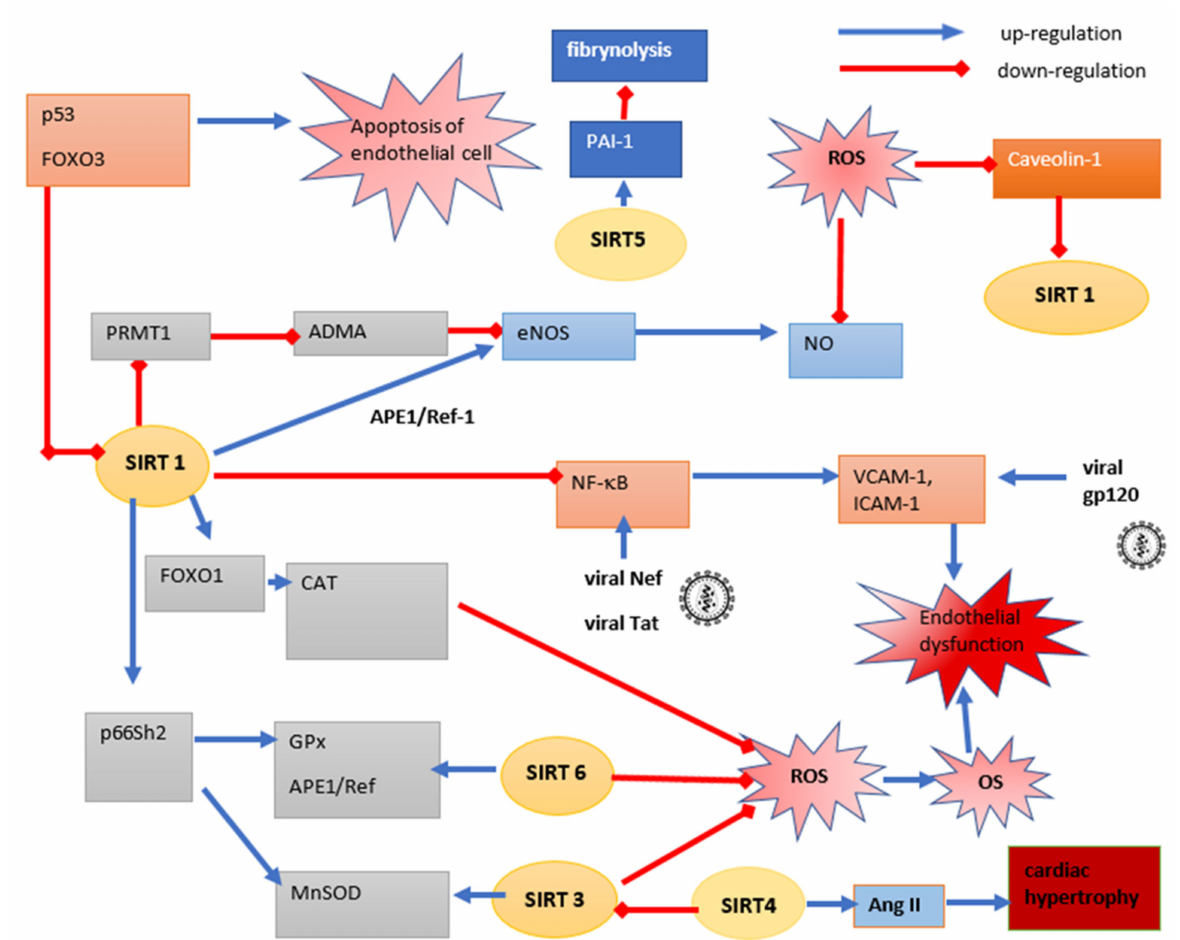
Figure 3. Scheme of connection between cardiovascular disorders, sirtuins and HIV infection. SIRT1 deacetylate PRMT1 and decrease levels of ADMA—eNOS inhibitor. SIRT1 is also responsible for deacetylation of eNOS, which increases enzyme activity and the production of NO. Endothelial SIRT1 activity against eNOS is promoted by APE1/Ref-1. SIRT1 decrease activity of p53, preventing process of apoptosis in endothelial cells. SIRT1 also deacetylates FOXO1, which has a positive effect on the regulation of apoptosis and cell cycle regulation. Decetylated FOXO1 increases the concentration of CAT and MnSOD. SIRT1 deacetylates Lys-310 in the RelA/p65 complex in NF- κ B, suppressing its pro-inflammatory activity in response to OS, and inhibits the synthesis of pro-inflammatory cytokines or thrombotic factors (ICAM-1, VCAM-1). The protective role of SIRT3 is primarily associated with antioxidant protection through the activation of SOD2 and CAT through deacetylation of the FOXO3a and protection against cardiomyocyte apoptosis. In contrast to SIRT3, SIRT4 decreases mitochondrial MnSOD activity. By interacting with AngII, SIRT4 is also a contributing factor to cardiac hypertrophy. SIRT4 also regulates platelet function and the formation of arterial thrombus, by increasing the expression levels of the fibrinolysis inhibitor PAI-1. ROS, reactive oxygen species; OS, oxidative stress; SIRT1, 3, 4, 5, 6, sirtuin 1, 3, 4, 5, 6; eNOS, nitric oxide synthase 3; ADMA, asymetric dimethylarginine; PRMT1, arginine-1 protein transferase; APE1/Ref-1, purinic/apyrmidinic endonuclease 1/redox factor-1; FOXO3, forkhead box O3; VCAM-1, vascular cell adhesion molecule 1; ICAM-1, intercellular adhesion molecule 1; CAT, catalase; MnSOD, manganese-dependent superoxide dismutase; GPx, glutathione peroxidase; NF- κ B, nuclear factor kappa-light-chain-enhancer of activated B cells; Ang II, angiotensin II; PAI-1, plasminogen activator